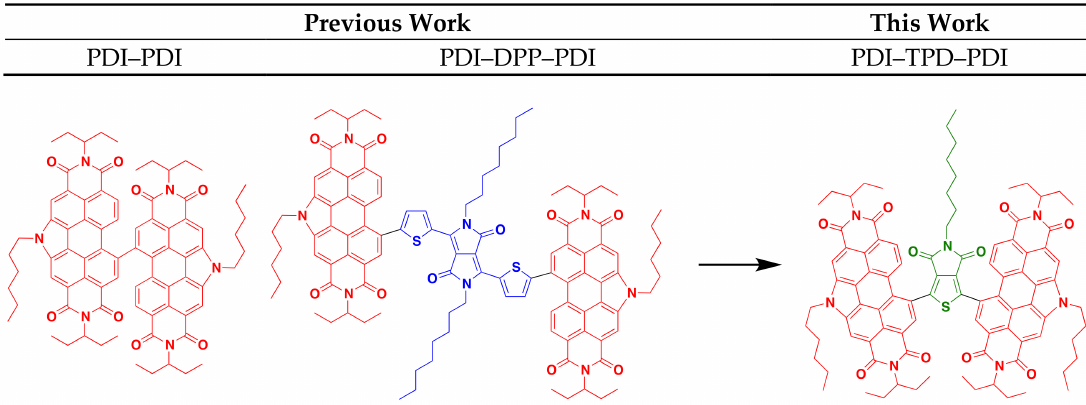
Figure 1. PDI-substituted non-fullerene acceptors previously reported and presented in this